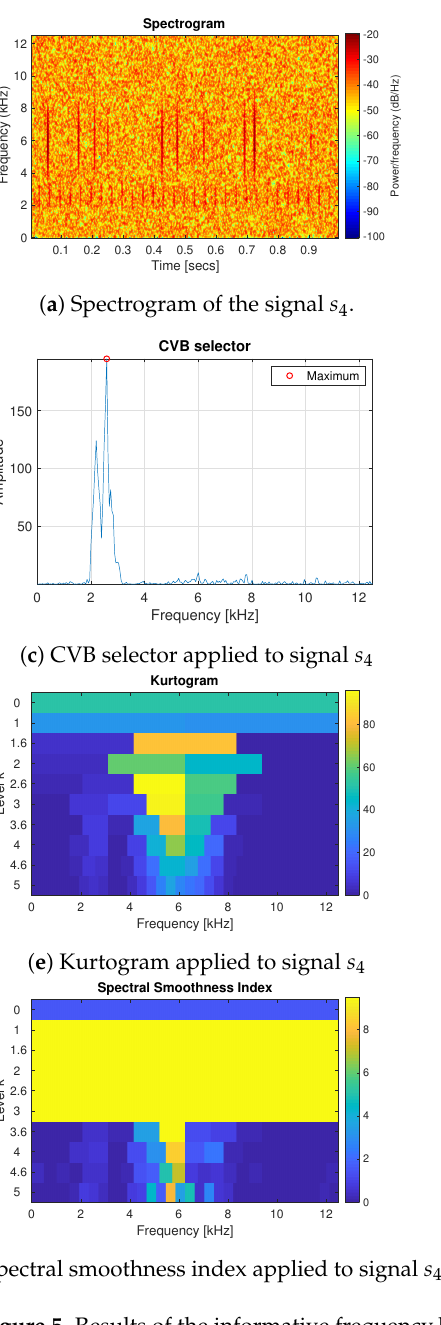
Figure 5. Results of the informative frequency band selection for 7 different methods for the signal s 4